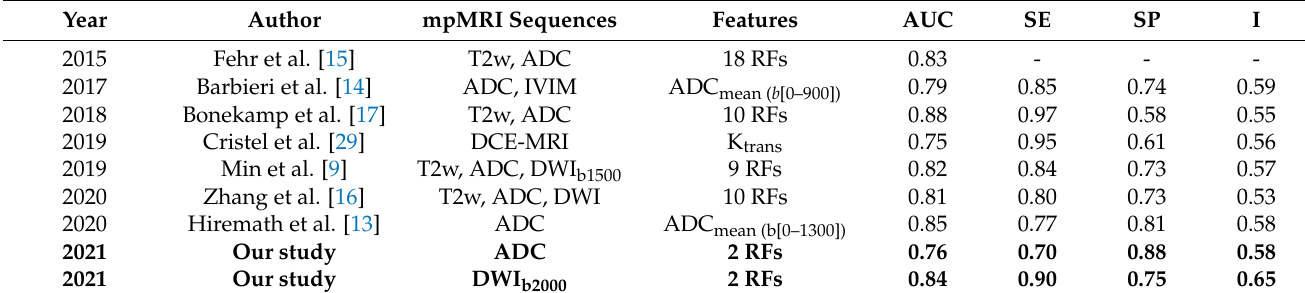
Table 3. Comparison of our findings with the scientific works published since 2015 (from PubMed database) predicting csPCa (independently of the lesion